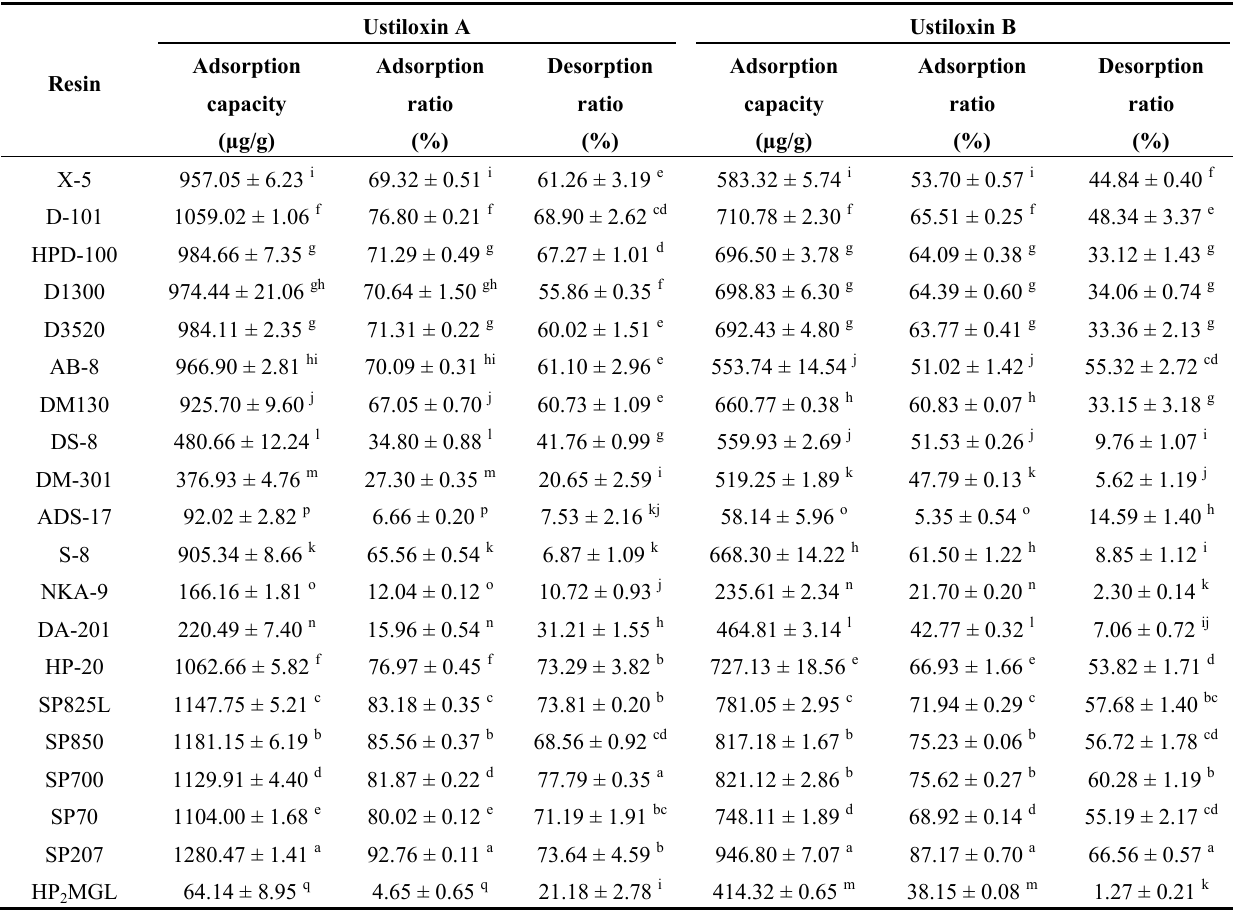
Table 1. Adsorption capacities, adsorption ratio and desorption ratio of the macroporous resins for ustiloxins A and